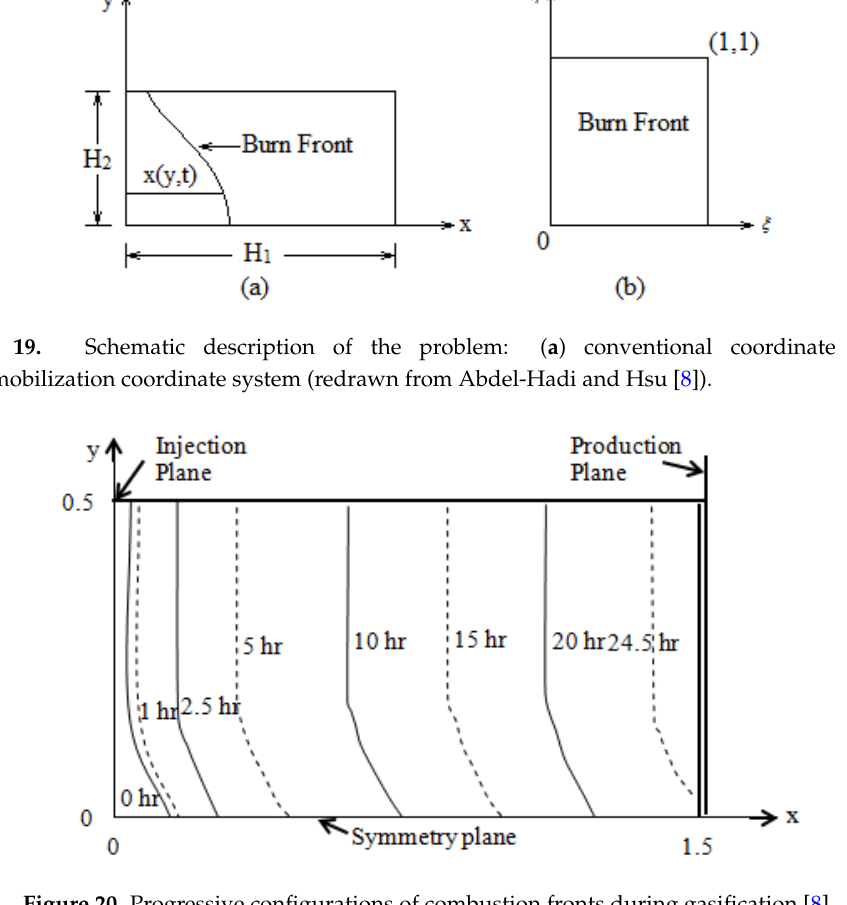
Figure 20. Progressive configurations of combustion fronts during gasification [8].